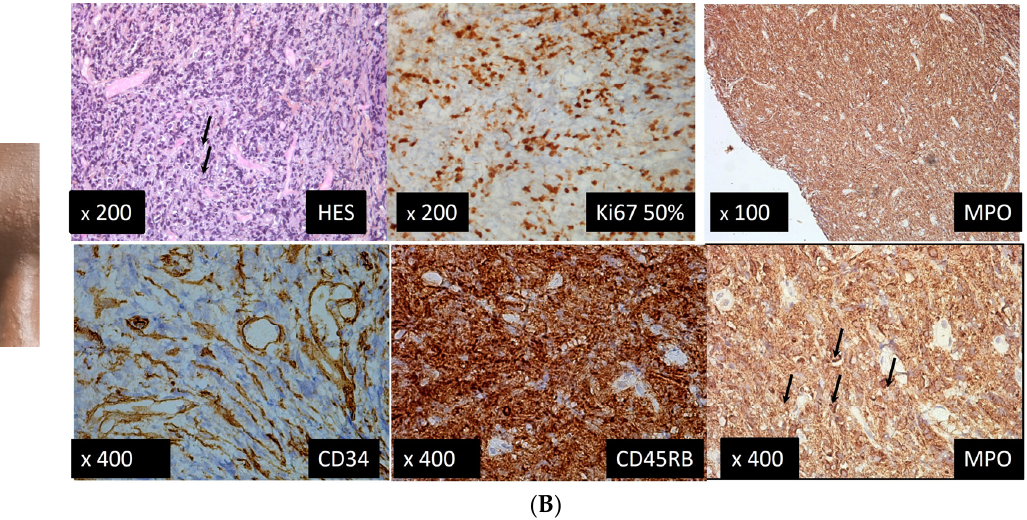
Figure 6. Case 6. ( A ) Feature of lymphoid infiltration of the nasal and superonasal conjunctiva in right eye; ( B ) Three out of 4 fragments of 5 × 8 mm that were analyzed revealed a diffuse high- grade tumor infiltration by blast cells, some of them with apparent nucleoli. The immunostainings found positive markers CD45RB, CD68KP, MPO and Ki67 on 50% of the cells, and negative mark- ers CD34-, CD3- CD20-. The arrows indicate some blast